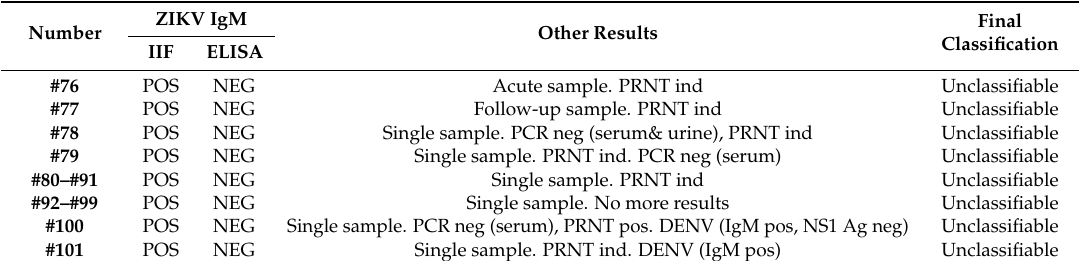
Table 4. Unclassifiable discrepant